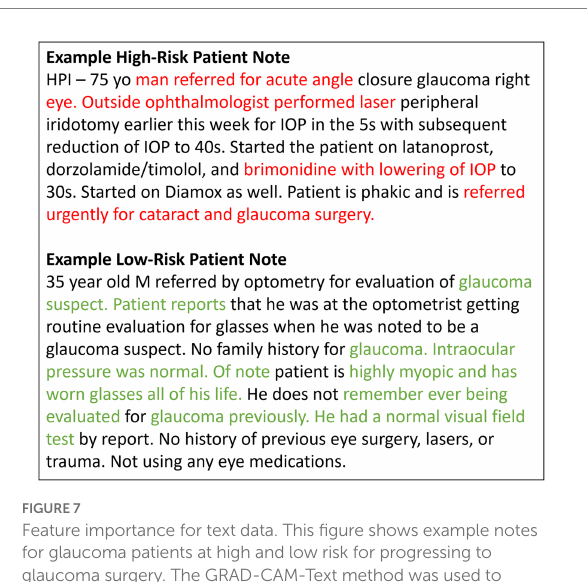
FIGURE 7 Feature importance for text data. This figure shows example notes for glaucoma patients at high and low risk for progressing to glaucoma surgery. The GRAD-CAM-Text method was used to identify words important to the model prediction, highlighted in red for predicting surgery and in green for predicting no